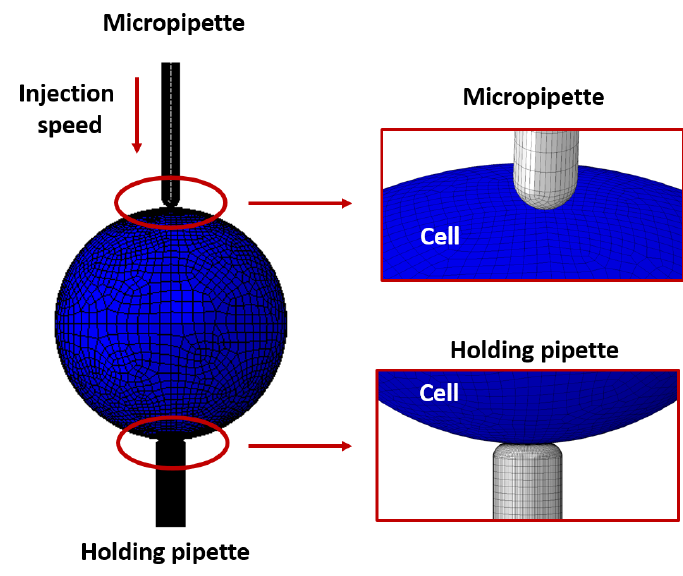
Figure 6. Schematic of finite element (FE) model for Intracytoplasmic Sperm Injection